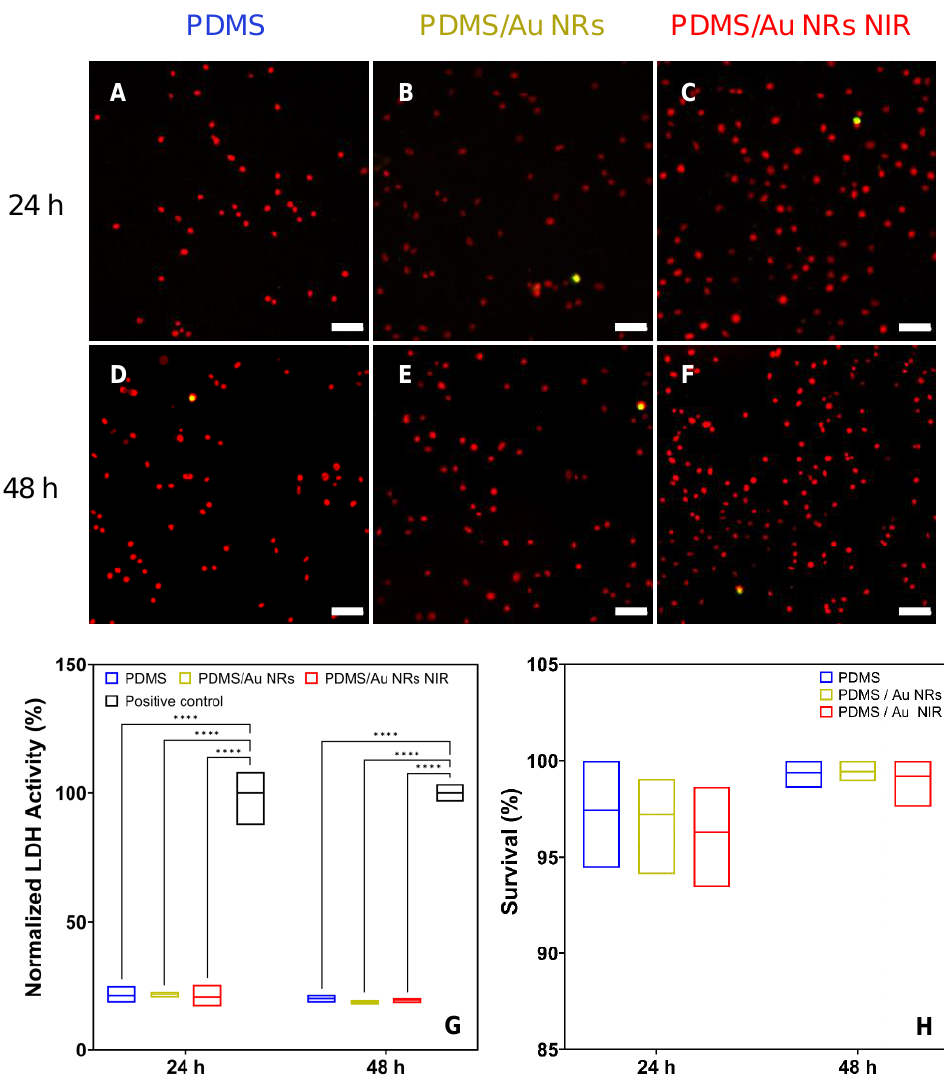
Figure 2. ( A – F ) cLSM images of fibroblast plasma membranes cultured on the PDMS films and stained with a commercial LIVE/DEAD assay showing live cells in red and cells with a compromised plasma membrane in green. Scale bar 80 µm. ( G ) LDH assay performed at 24 and 48 h for three independent biological replicates. Triton X-100 was used as a positive control. ( H ) Cell survival rate cultured on the control and irradiated films at 24 and 48 h of cultivation. Two-way ANOVA, post hoc Tukey’s test, **** p ≤ 0.0001.